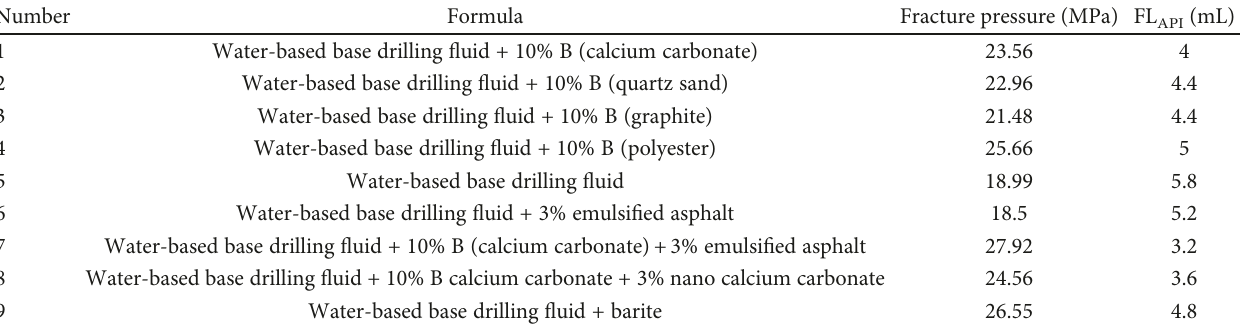
Table 7: The results of the core fracturing experiment under the action of di ff erent materials.